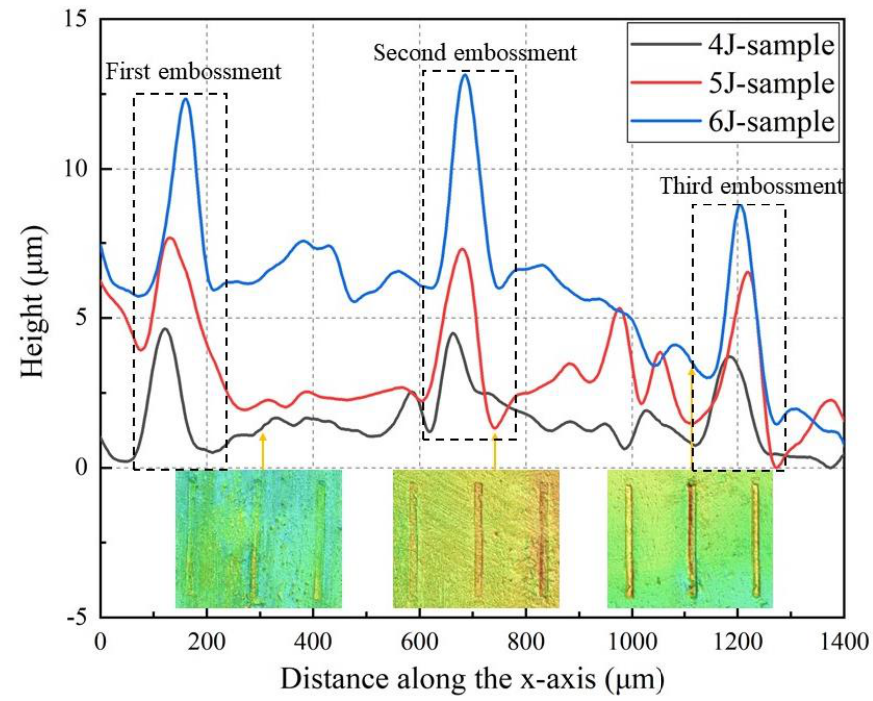
Figure 10. Surface topography of the samples treated with different laser energies.